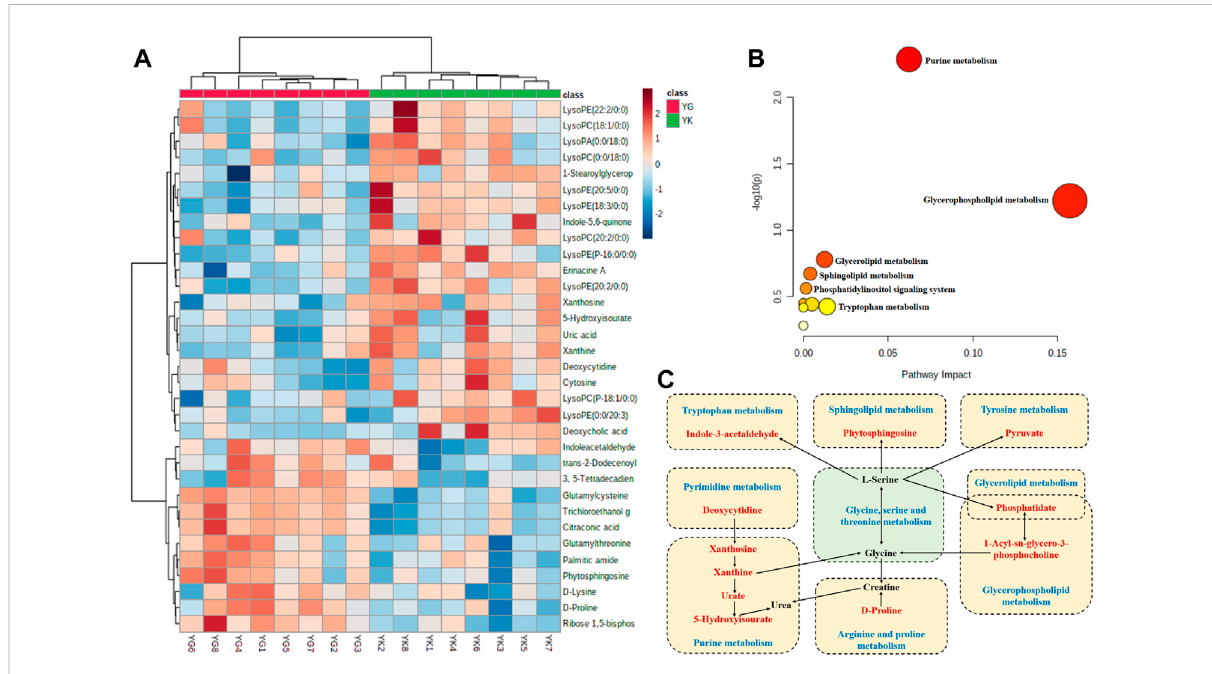
FIGURE 8 Metabolites analysis of rat serum samples in YIN-K and YIN-G groups. Note: (A) cluster analysis; (B) pathway analysis; (C) summary of metabolites and pathways (blue words indicate metabolic pathways, red words indicate identi fi ed discriminant metabolites in present research, and black words indicate the related endogenous